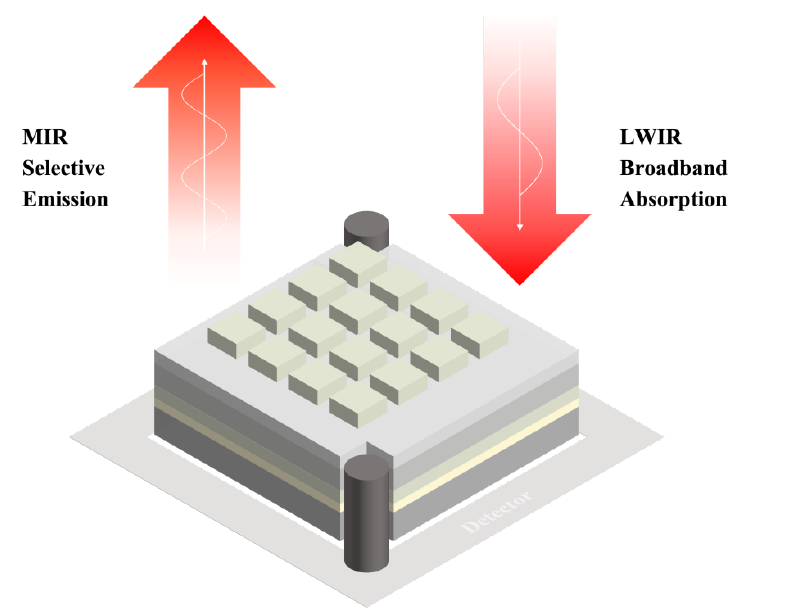
Figure 9. Demonstration of the designed dual-function metasurface.